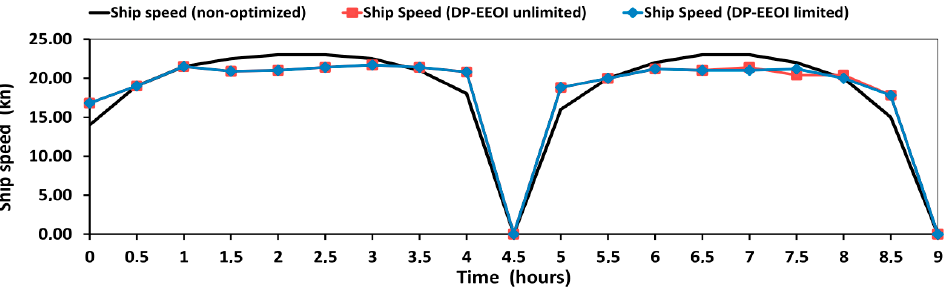
Figure 8. Optimal generator set power production, non-optimized ship electric load (PSO-EEOI limited).